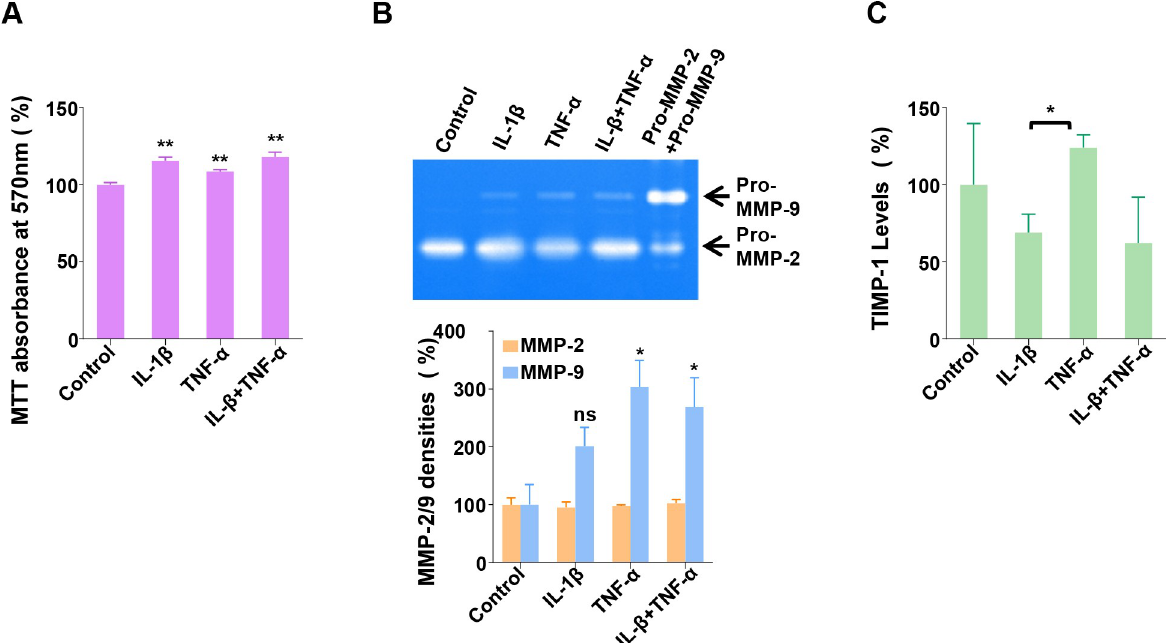
Fig 1. Cytokine regulation of the secretion of MMP-9 and TIMP-1 from MIO-M1 cells. (A) MIO-M1 cells were treated or untreated with IL-1 β and TNF- α , at 10 ng/mL, alone or in combination, for 24 h, and then subjected to MTT assay to measure viable cell densities. Control refers to untreated samples. Relative cell densities are presented as % mean ± SE (n = 3), with Control set as 100%. �� , p < 0.01 (vs. Control) (B) The cells were treated in the same way as in (A), and then CMs were collected, to perform gelatin zymography assay. (Top) CMs of the same volume from each treatment was subjected to gelatin zymography. One representative zymogram is shown to visualize secreted MMPs. Recombinant human pro-MMP-2 and pro-MMP-9 (Pro-MMP-2+Pro-MMP-9) were applied to the gel before electrophoresis as a control. (Bottom) The density of each MMP band was quantified using Image J software. The individual values of MMP band densities were normalized by the corresponding MTT absorbance values (n = 3). ns, not significant (p > 0.05 vs. Control); � , p < 0.05 (vs. Control) (C) Secreted TIMP-1 levels in the CMs were measured using TIMP-1 ELISA assay (n = 3), and then normalized by the corresponding MTT absorbance values. � , p < 0.05 (IL-1 β vs. TNF- α ).